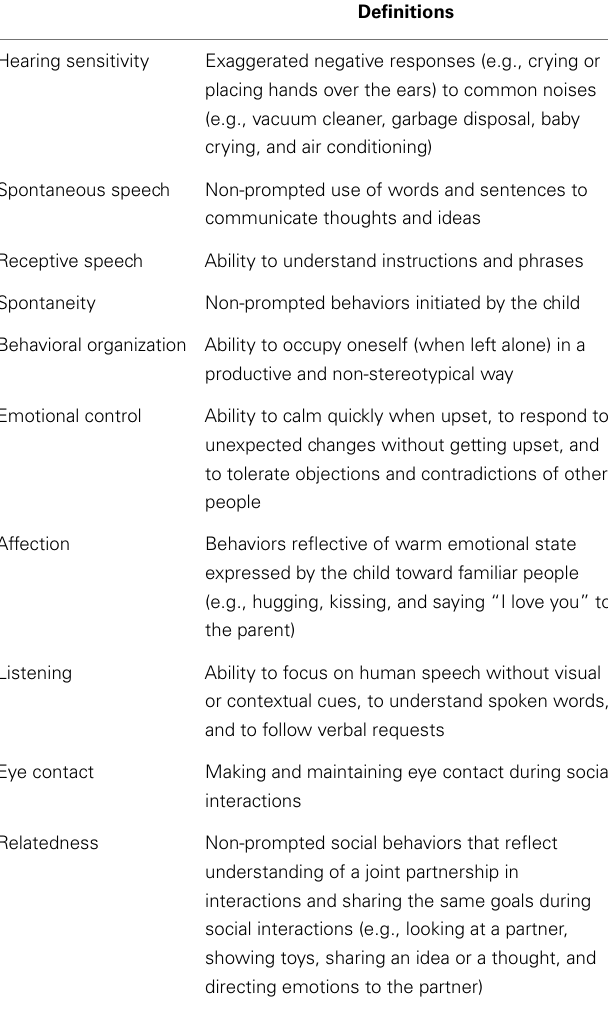
Table 2 | Behavioral domains and explanations for the structured parent questionnaire